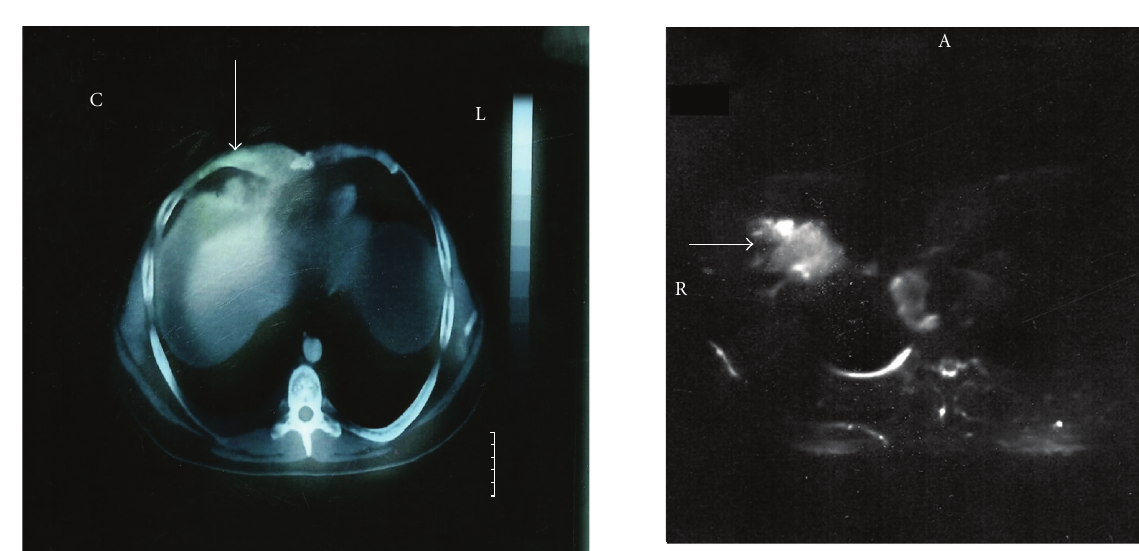
Figure 3: Axial enhanced CT-image of the lower part of the chest (mediastinal window) shows small pleural e ff usion and an epiphrenic node at the right. Ascites and thickness of the right crus are also noticed.